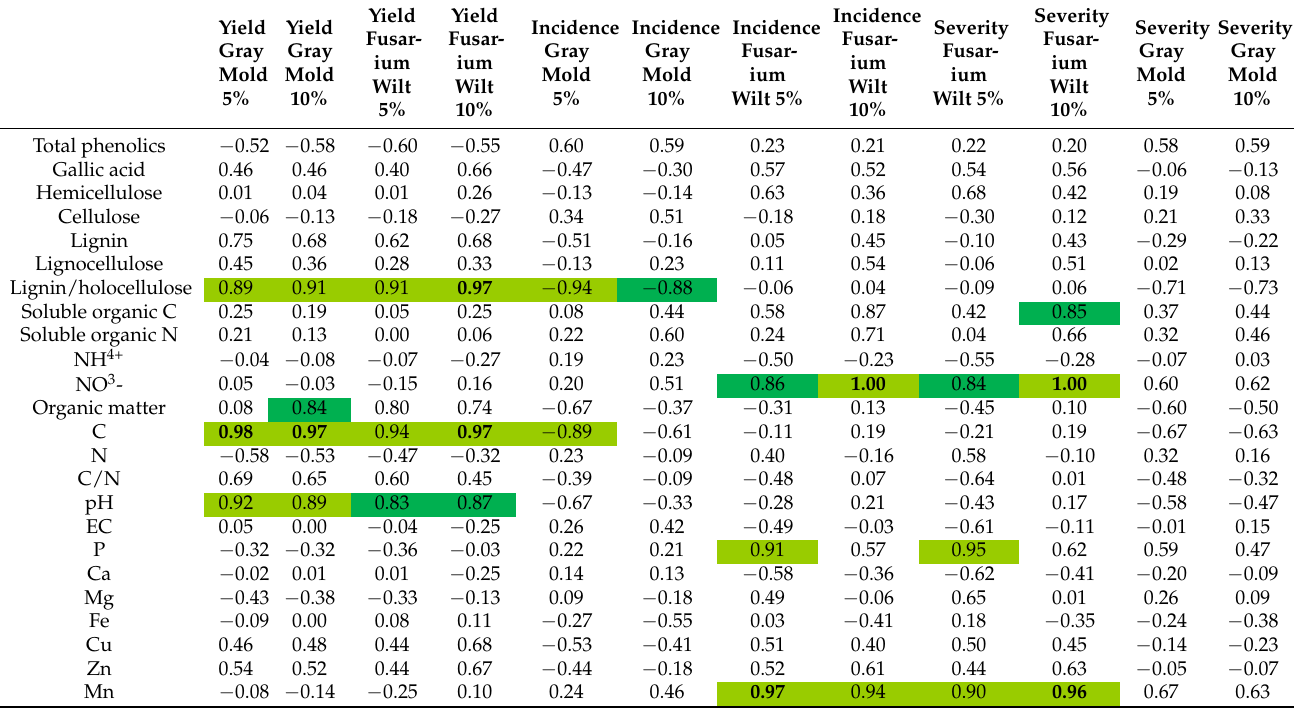
Table 2. Correlations among disease prevalence of gray mold and Fusarium wily on lettuce, and physicochemical parameters. All data from Tables S1–S4 were submitted to a Pearson correlation analysis. Green color indicates p < 0.10; light green color indicates p < 0.05; light green color with bold numbers indicates p <